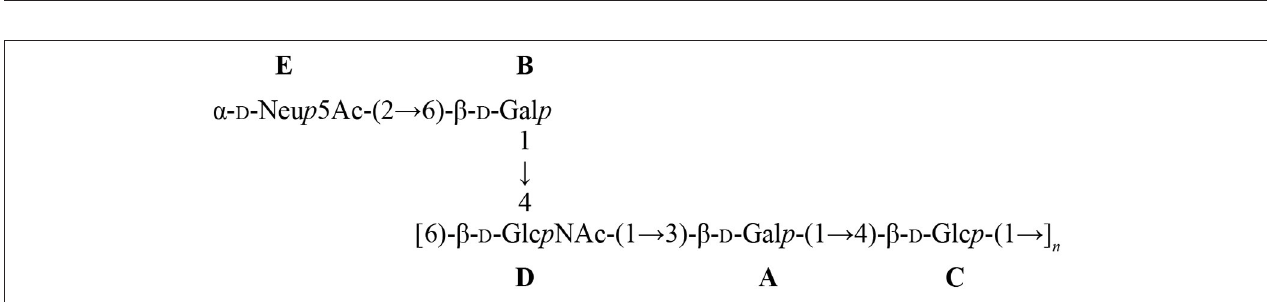
SCHEME 1 | Structure of the GBSIIIsia2,6 mutant CPS with residue labels.